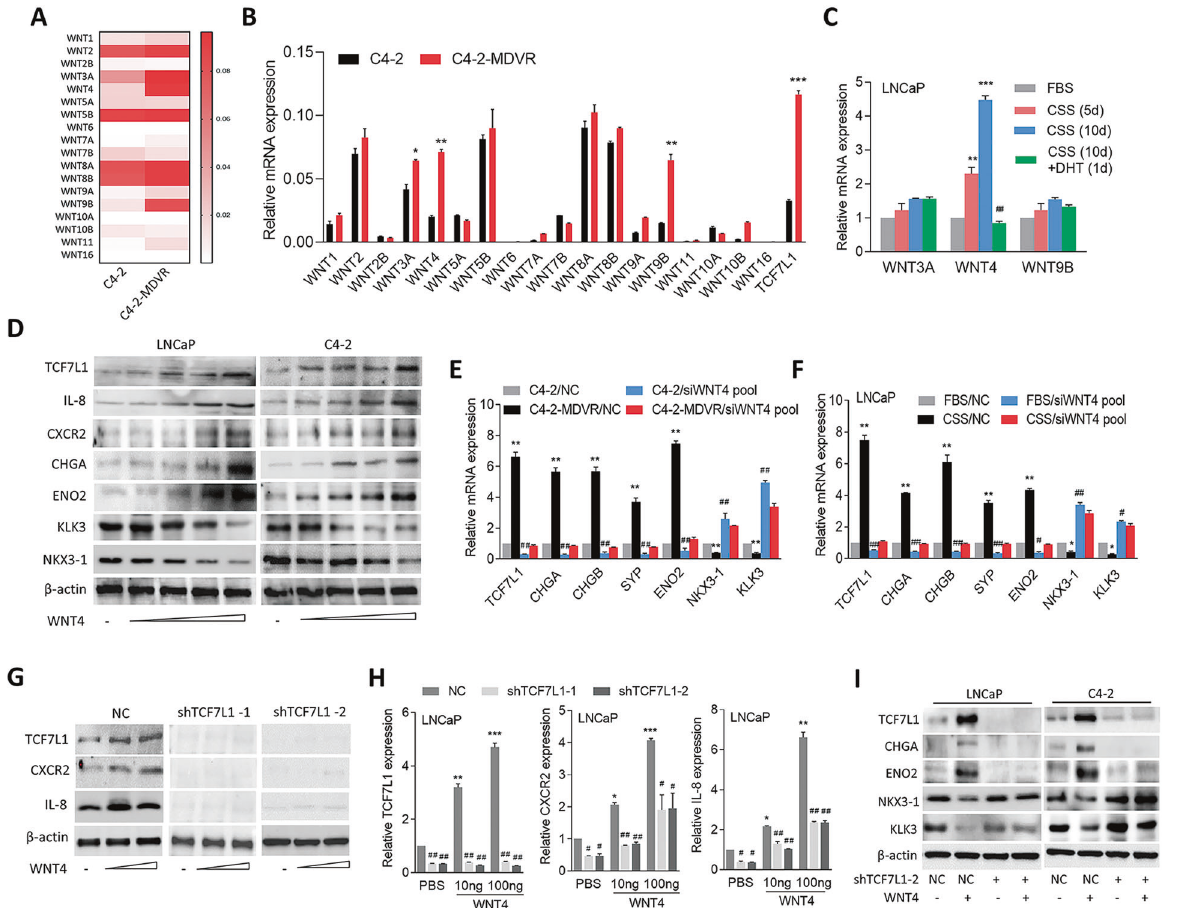
Fig. 5 ADT-resistance induced-TCF7L1/IL-8/CXCR2 upregulates NED through increased WNT4. A WNT ligand mRNAs as determined by a human RT 2 Pro fi ler WNT signaling PCR Array analysis of C4-2-MDVR and C4-2 cells. The intensity was determined by the multiple of change of C4-2-MDVR/C4-2 as the magnitude of log2-transformed data from each mRNA level. B WNT ligands and TCF7L1 mRNAs in C4-2 and C4-2- MDVR cells, by an RT-qPCR. * p < 0.05, ** p < 0.01, *** p < 0.001. C RT-qPCR showing WNT3A, WNT4, and WNT9A mRNA levels in LNCaP cells after treatment with CSS-containing medium for 5 or 10 days and subsequent treatment with 10 nM DHT on day 10 for 1 day. D Immunoblots showing TCF7L1, IL-8, CXCR2, CHGA, ENO2, KLK3, and NKX3-1 protein levels in LNCaP and C4-2 cells following increased WNT4 protein treatment for 48 h. E RT-qPCR showing TCF7L1, NE markers (CHGA, CHGB, SYP, and ENO2), and androgen-responsive genes (NKX3-1 and KLK3) mRNA levels in C4-2 and C4-2-MDVR cells following WNT4-knockdown by siWNT4 SMARTpool. F TCF7L1, NE marker, and androgen-responsive gene mRNA levels in LNCaP cells following WNT4-knockdown by siWNT4 SMARTpool in 10% FBS-containing medium or CSS-containing medium for 10 days. G Protein levels of TCF7L1, CXCR2, and IL-8 in PC3 cells expressing a nontarget control (NC) or TCF7L1 shRNA vector following increased WNT4 protein treatment for 48 h. H mRNA levels of TCF7L1, CXCR2, and IL-8 in LNCaP cells expressing the NC or TCF7L1 shRNA vector following increased WNT4 protein treatment for 48 h, by an RT-qPCR analysis. * vs. PBS; # vs. the NC. Data from the quanti fi cation of mRNA are presented as the mean ± SEM, n = 3 per group; by a two-way ANOVA. I TCF7L1, CHGA, ENO2, NKX3-1, and KLK3 protein levels in LNCaP and C4-2 cells expressing the NC or TCF7L1 shRNA vector following 100 ng/ml WNT4 protein treatment for 48 h as determined by